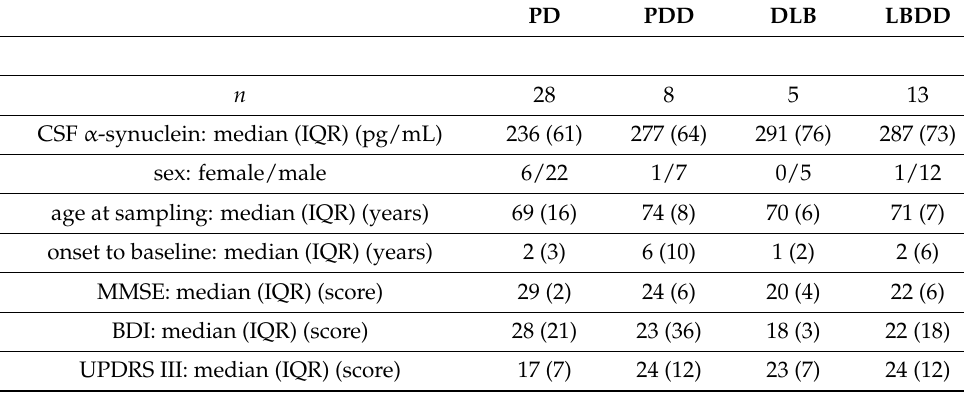
Table 1. Base line data and α -synuclein in the diagnostic groups. Table 1. Baseline data and α -synuclein in the diagnostic groups.